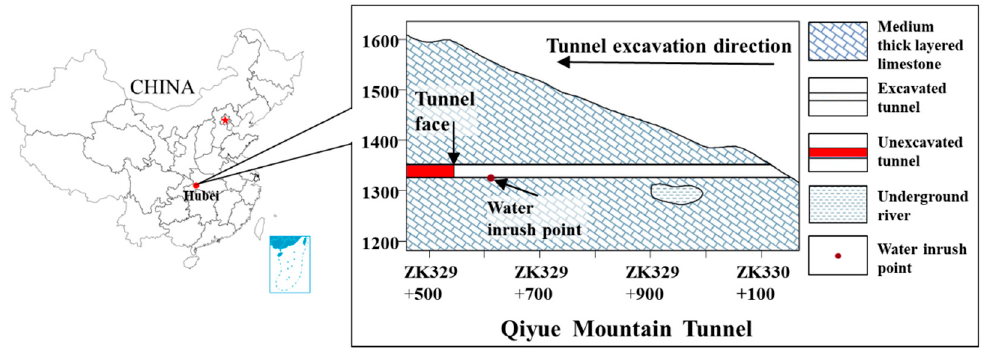
Figure 7. The positions of Qiyue Mountain tunnel and its longitudinal geological sections from west to east of the studied sections [14].